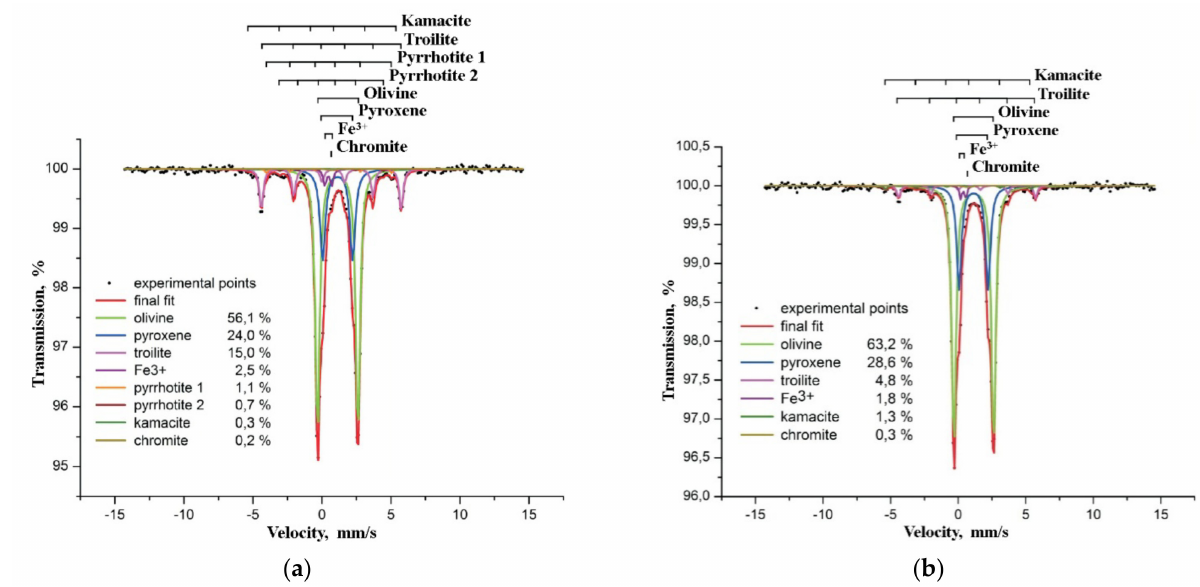
Figure 32. Room temperature Mössbauer spectra of equilibrated ordinary chondrites NWA 8590 LL6 ( a ) and Oued el Hadjar LL6 ( b ). Indicated components are the results of the fits. Adapted from Reference [104].